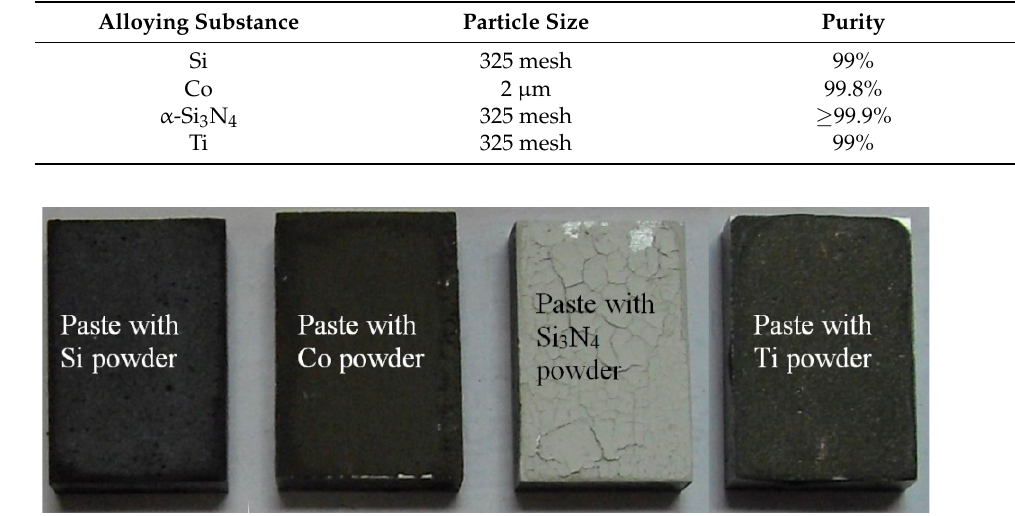
Table 1. The alloying substance particle size and its purity.